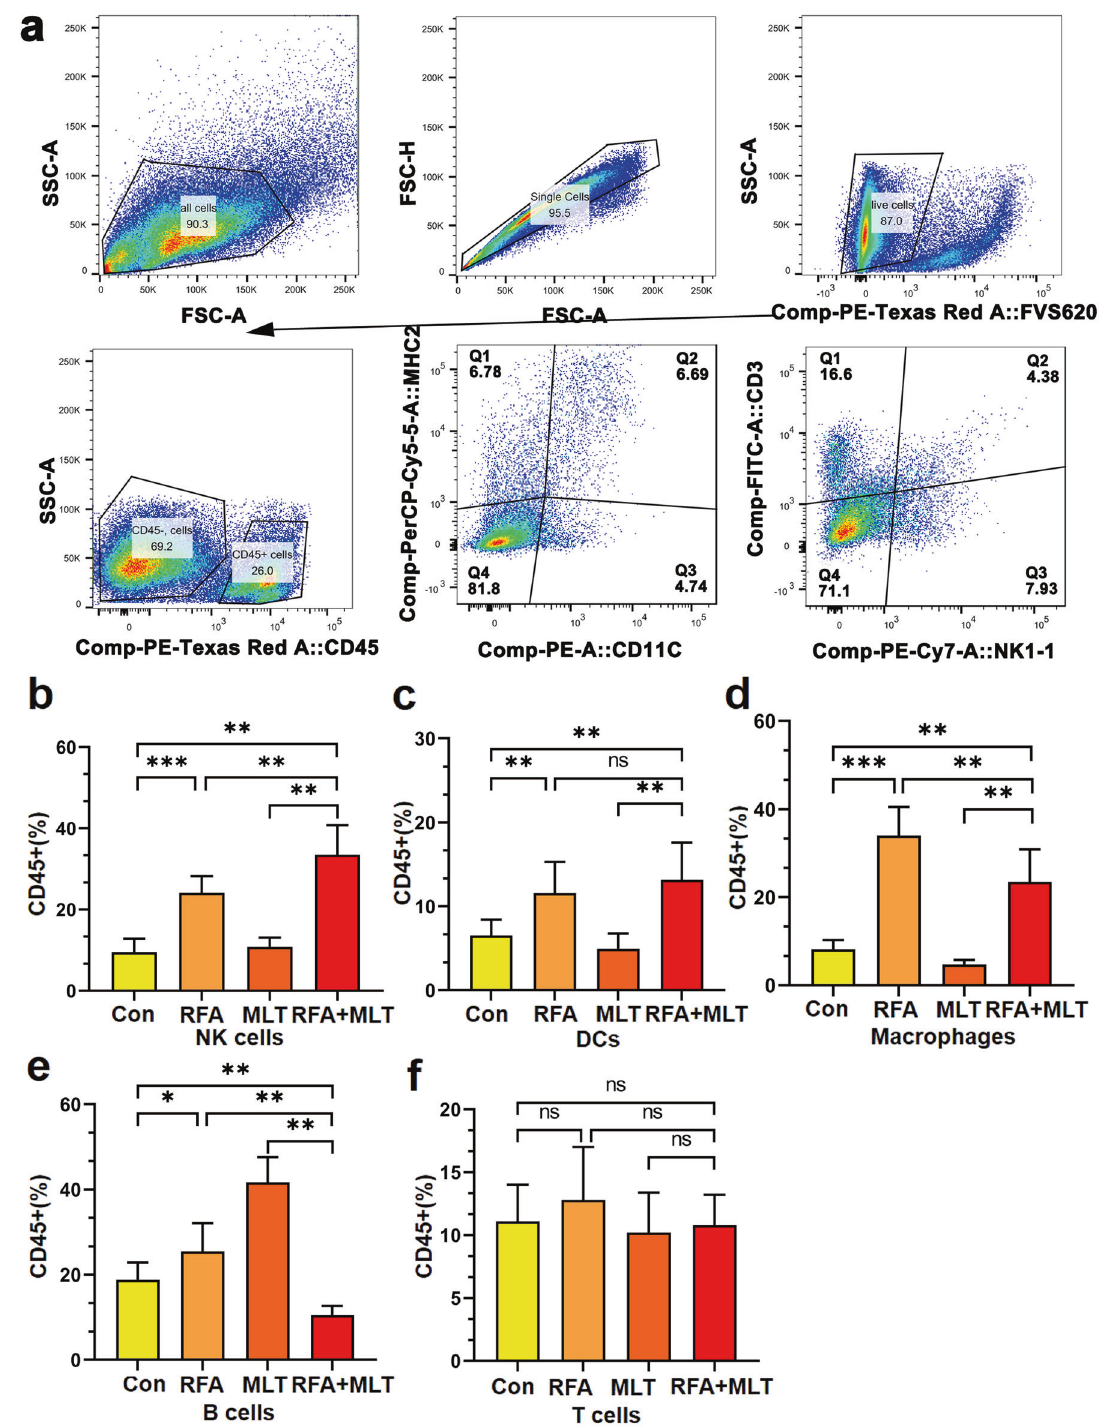
Fig. 3 MLT promotes RFA-induced tumor in fi ltration of NK cells. a Flow cytometry showing NK cells from tumor tissue in C57BL/6 mice. Changes in survival of in fl ammatory cells of b NK cells, c DCs, d macrophages, e B cells, and f T cells from the non-ablated tumor tissues in the Control, RFA, MLT, and RFA + MLT groups, and the percentage of different lymphocytes were analyzed based on 10 4 cells. (* P < 0.5, ** P < 0.01; *** P < 0.001; ns, no signi fi cance) Western blotting and reverse transcriptase quantitative polymer- As shown in Fig. 5a, we further found that there were distinct ase chain reaction (PCR) were performed to assess whether cancer changes in pathways related to cancer cell proliferation and proliferation and malignancy-related pathways (MAPK, NF к B, Wnt, apoptosis (mitogen-activated protein kinase (MAPK), 22 P53, 23 ) as Hif, Hedgehog pathways, and P53) were shifted to a lower well as in pathways related to cancer malignancy and stemness malignancy state after RFA + MLT treatment. As shown in Fig. 5b, (nuclear factor к B (NF к B), 24,25 Wnt, 26 Hif1, 27 and Hedgehog 28 ).